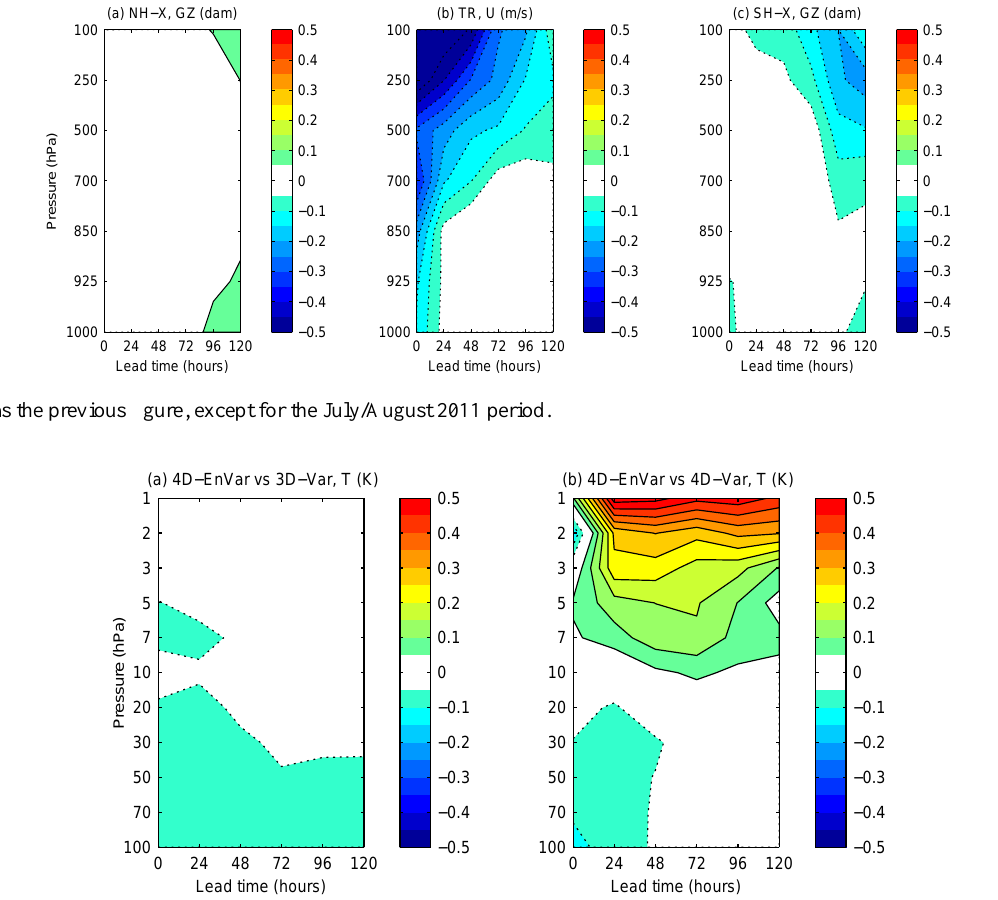
Fig. 9. The difference in standard deviation relative to ERA-Interim reanalyses in the stratosphere for (a) the EnVar-minus-3D-Var forecasts and (b) the EnVar-minus-4D-Var forecasts for the February/March 2011 period for temperature over the entire global